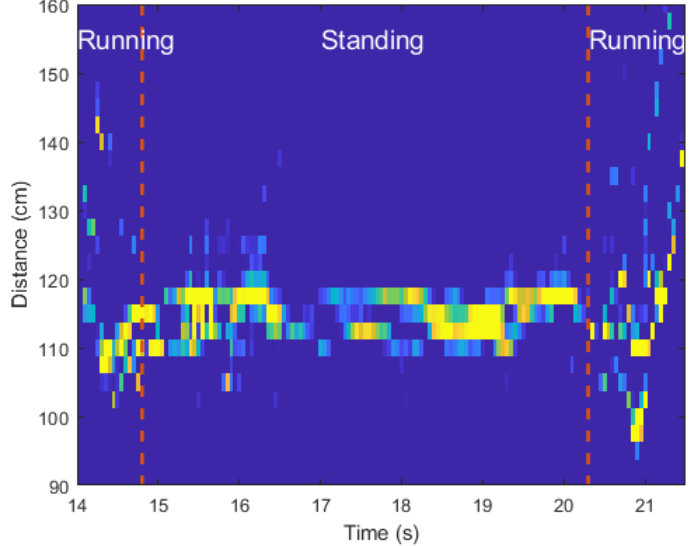
Figure 13. Spectrogram according to changes in human motion: From running to standing, and then running